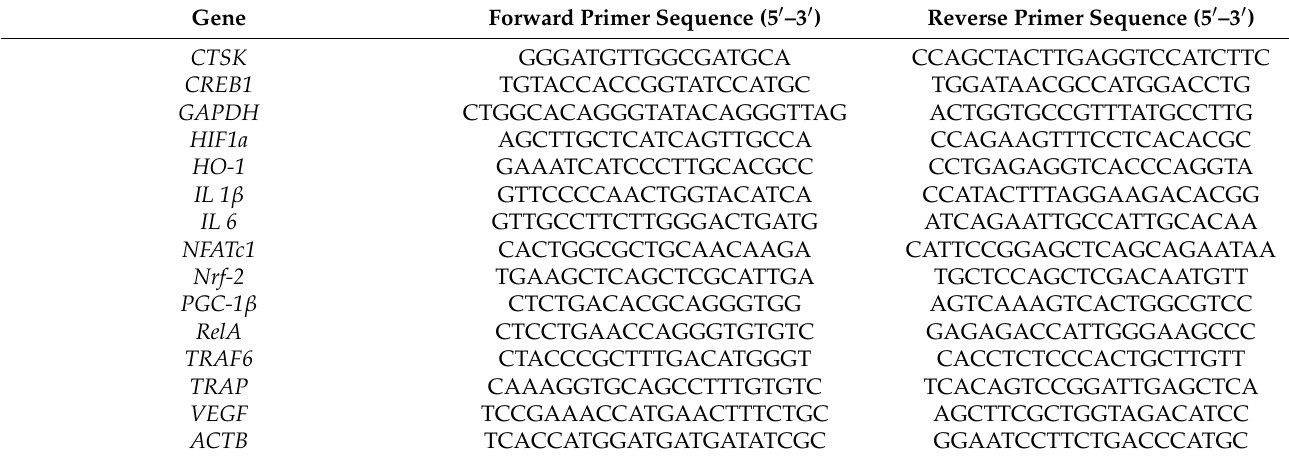
Table 1. Primers used for quantitative real time polymerase chain reaction analysis. Gene Forward Primer Sequence (5 (cid:48) –3 (cid:48) ) Reverse Primer Sequence (5 (cid:48) –3 (cid:48) )